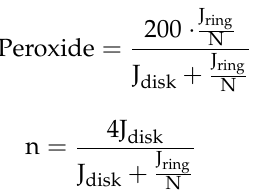
N 2 atmosphere. Figure S2: XRF spectra of as-synthesized samples (a–e) and XRD pattern of cig_BM (f). Table S1: Fitting result of Raman bands as a sum of bands with Breit–Wigner–Fano line shape. Figure S3: SEM micrographs of spectra of cig_450 (a,b), cig_600 (c,d) and cig_900 (e,f). Figure S4: Electron microscopy investigation of cig_600 (a–d) and cig_900 (e–h). Low magnification HRTEM (a,e); high magnification HRTEM image (b,f); HAADF images (c,g); EDX maps of C, Fe, Ca and O (d,h). Figure S5: XPS survey spectra of (a) cig_450, (b) cig_600, (c) cig_750 and (d) cig_900. Table S2: Percentage composition of the samples obtained by XPS analysis. Figure S6: The component ratio of the nitrogen moieties detected by high-resolution N 1s spectra Figure S7: C 1s high-resolution spectra of (a) cig_450, (b) cig_600, (c) cig_750 and (d) cig_900 with raw data. Figure S8: E 1/2 vs. T plots obtained in (a) acidic, (b) alkaline and (c) neutral environments. The red line observed in graphs (a) and (b) refers to the linear fit of data. Figure S9: Accelerated stability tests of cig_450 conducted in 0.1 M PBS: (a) Disk current density (J disk ) and (c) Ring current density (J ring ) recorded at 1600 rpm and 5 mV s − 1 , (b) % Peroxide and (d) the number of transferred electrons (n). Figure S10: Accelerated stability tests of cig_450 conducted in 0.1 M KOH: (a) Disk current density (J disk ) and (c) Ring current density (J ring ) recorded at 1600 rpm and 5 mV s − 1 , (b) % Peroxide yield and (d) the number of transferred electrons